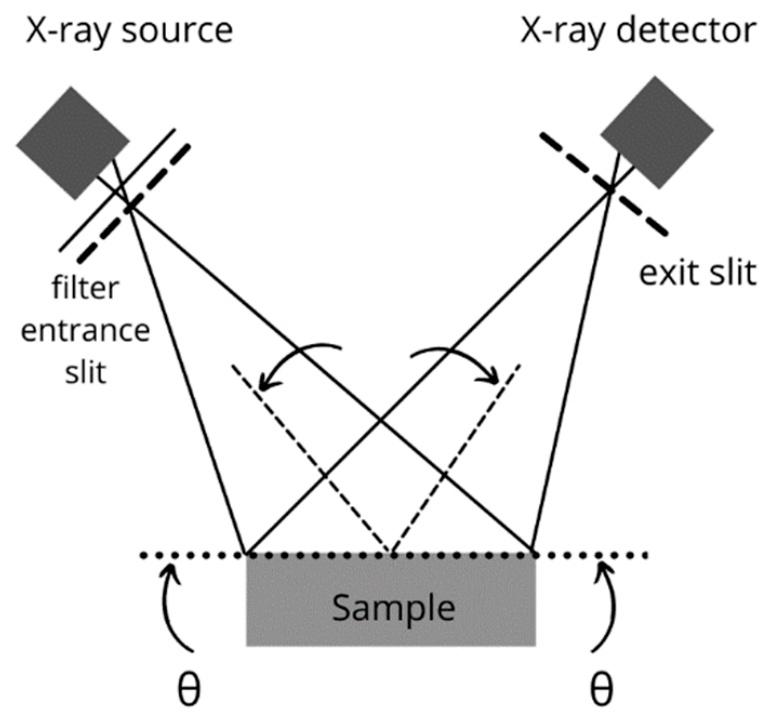
Figure 3. Scheme of testing using the X-ray diffraction method.